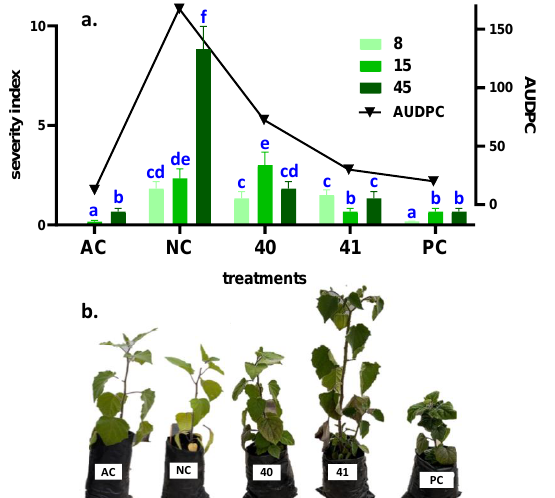
Figure 4. Effects of 40 , 41 , and commercial fungicide propiconazole as the positive control (PC) on the disease progression of Fusarium oxysporum- infected cape gooseberry ( Physalis peruviana L. ) plants at 8, 15, 45 days after infection (dai) compared to negative (NC) and absolute (AC) controls. ( a ) Vascular wilt severity index (bars, left Y -axis) over time (8, 15, and 45 dai) and area under the disease progress curve (AUDPC) (black line, right Y -axis) for infected plants at 45 dai. Severity index values are expressed as the mean ± standard deviation of six biological replicates (plants). Different blue lowercase letters over bars indicate statistically significant differences according to the Tukey test ( p < 0.05); ( b ) Comparison of the phenotypic cape gooseberry responses after in vivo experiment at 45 dai.